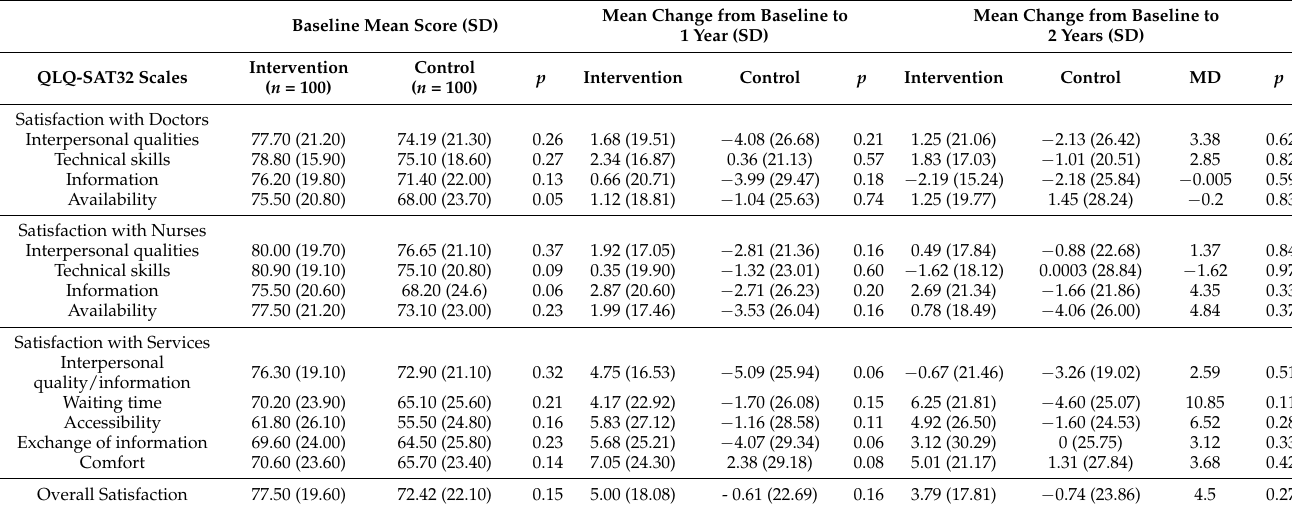
Table 4. Satisfaction with care endpoints at baseline and 1 and 2 years.